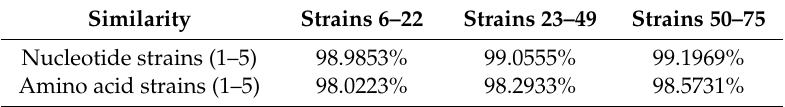
Table 6. Comparison of VP2 genes (nucleotide and amino acids) of five strains isolated in the 20th century and 70 strains isolated afterwards, classified into four groups in five years (strains 1–5: samples collected from 1900–2000; strains 6–22: 2001–2005; strains 23–49: 2006–2010; strains 50–75: